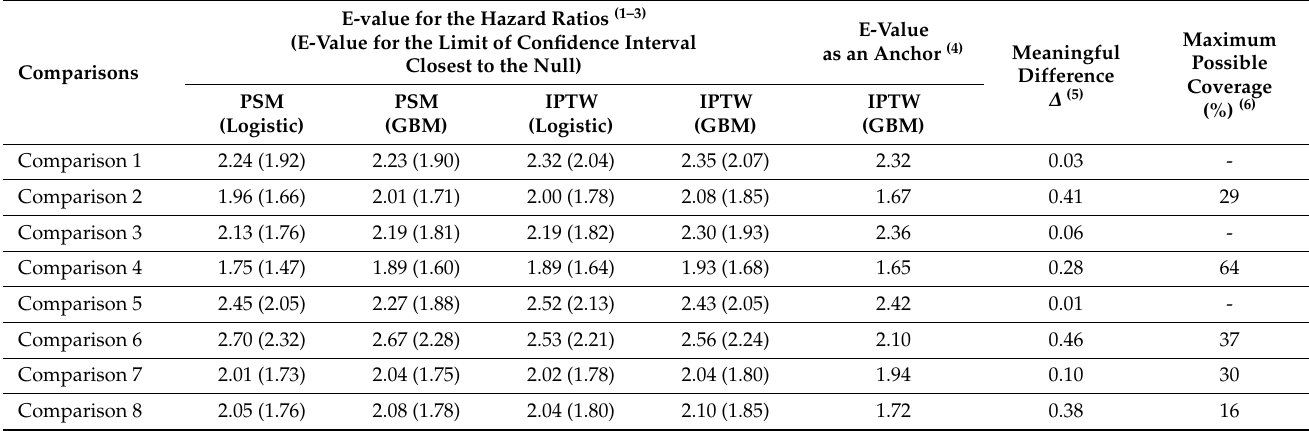
Table 2. E-values of the estimated hazard ratios for stroke or systemic